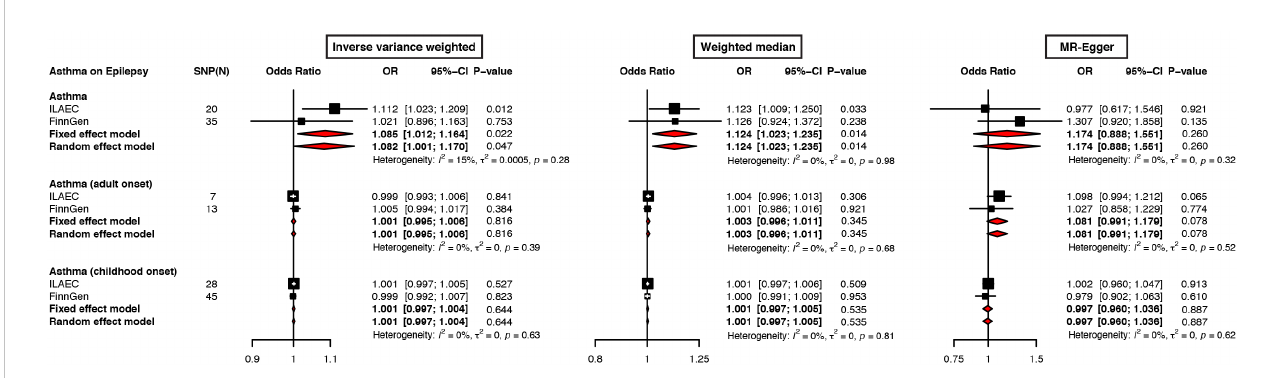
FIGURE 3 Forest plots of meta-analysis on ILAEC and FinnGen epilepsy GWAS datasets show the causal effects of asthma on epilepsy. The inverse variance weighted, weighted median, and MR-Egger regression were used to evaluate the causal effects of asthma on